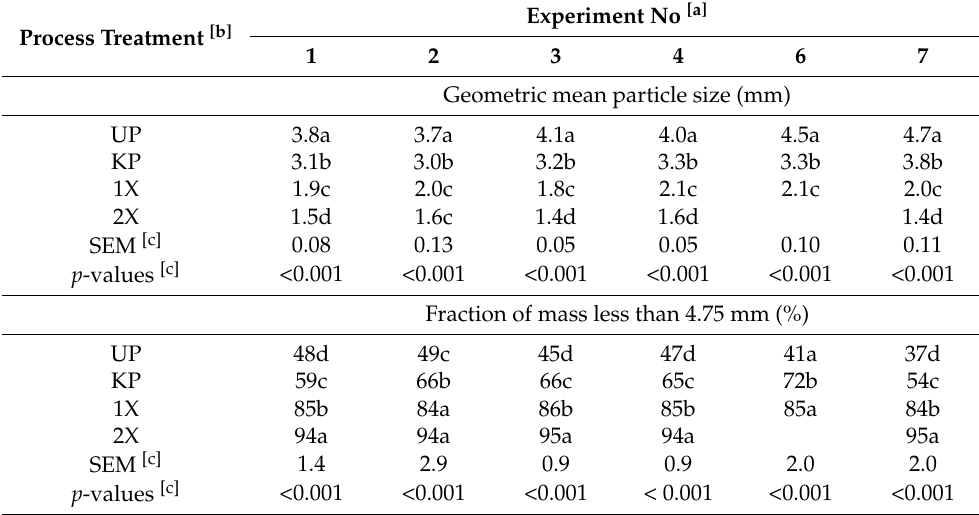
Table 4. Geometric mean particle size of the kernel fraction.